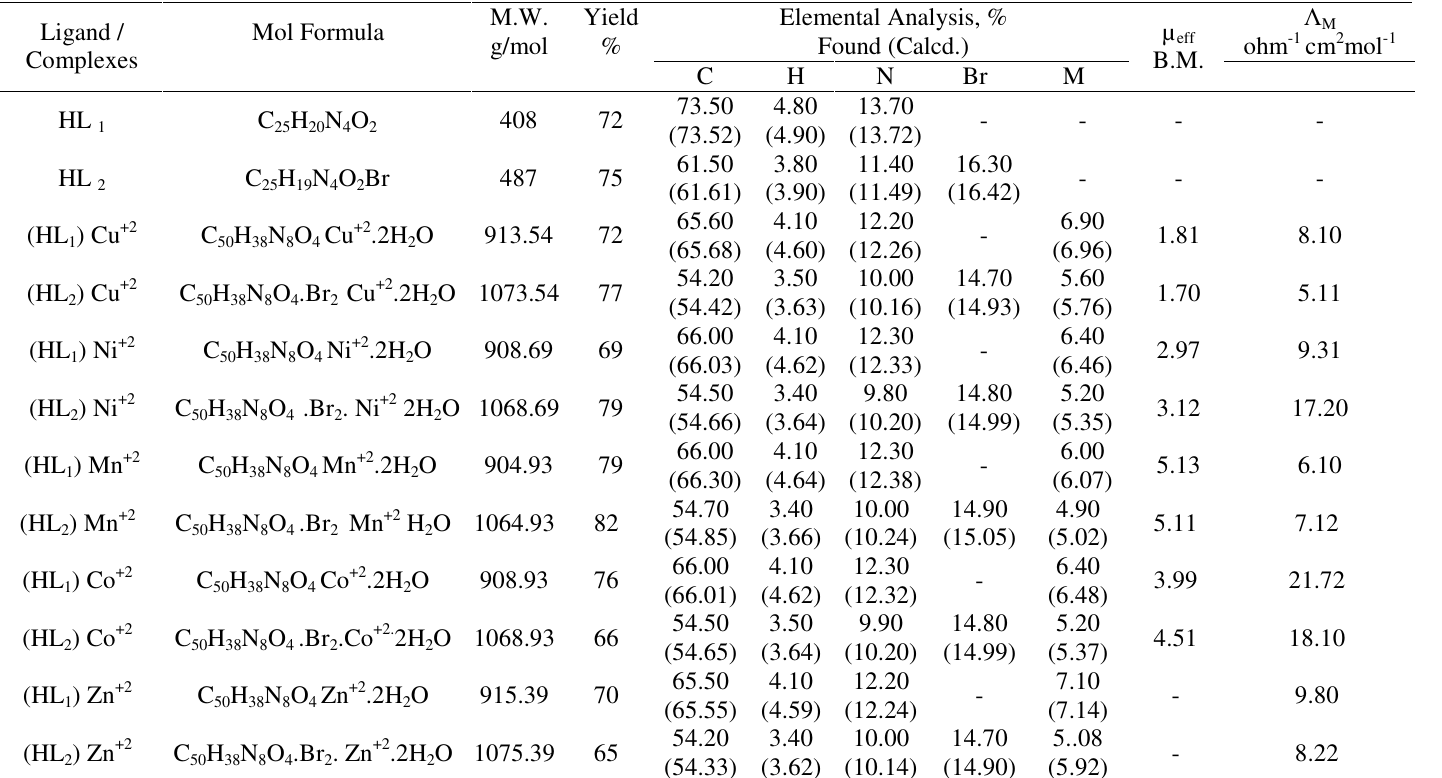
Table 1. Analytical and physical data of ligand and